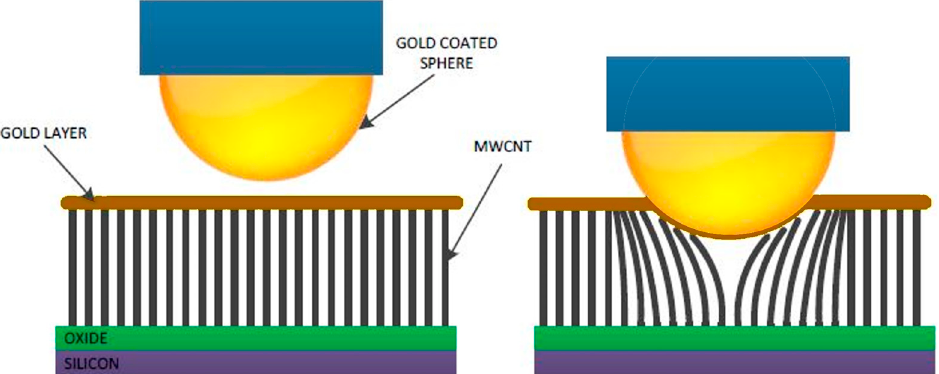
Figure 2. Illustration showing a composite contact formed by Au coating a field of vertically aligned multi-walled carbon nanotubes. The composite conforms to the incoming contact, enhancing the contact area and reducing the contact pressure [22].